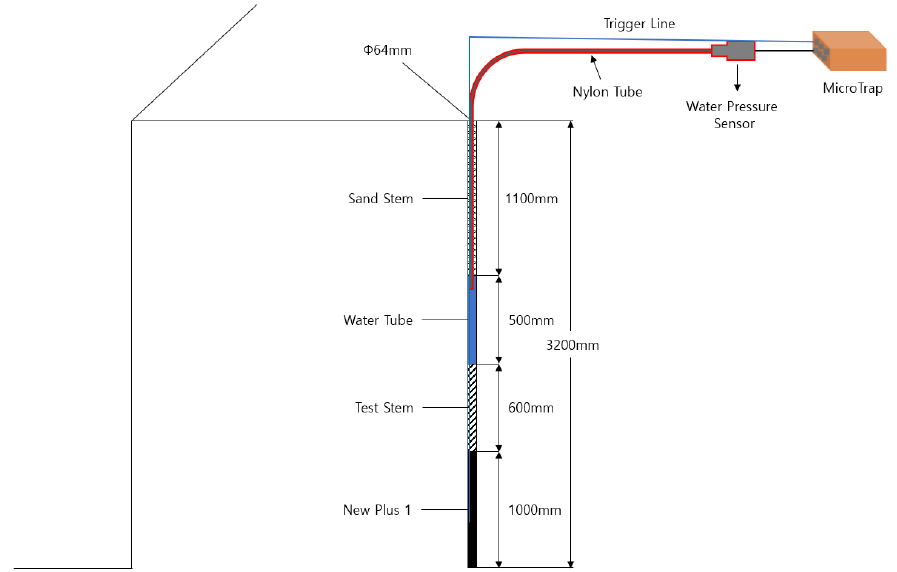
Figure 8. Schematic of the blast hole measurement system.